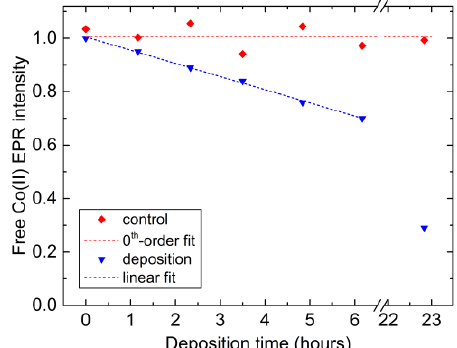
Figure 1. ( A ) X-band CW electron paramagnetic resonance (EPR) spectra of a cobalt oxide (Co-Pi) catalyst film electrodeposited at 0.9 V from an aqueous 1 mM Co(NO 3 ) 2 solution in 0.1 M Pi electrolyte (red) and Co(II) in the starting solution (blue) measured at T = 5 K and P MW = 6.3 mW. ( B ) Normalized EPR intensity of Co(II) in the Co-Pi film (red circles) and electrolyte solution (blue diamonds) as a function of P MW with T = 5 K. Simulations obtained using (1 + P / P 1 / 2 ) − 0.5 are shown with solid lines, with best fit P 1 / 2 values of 1 ± 0.2 mW for the solution and 945 ± 35 mW for the film species.